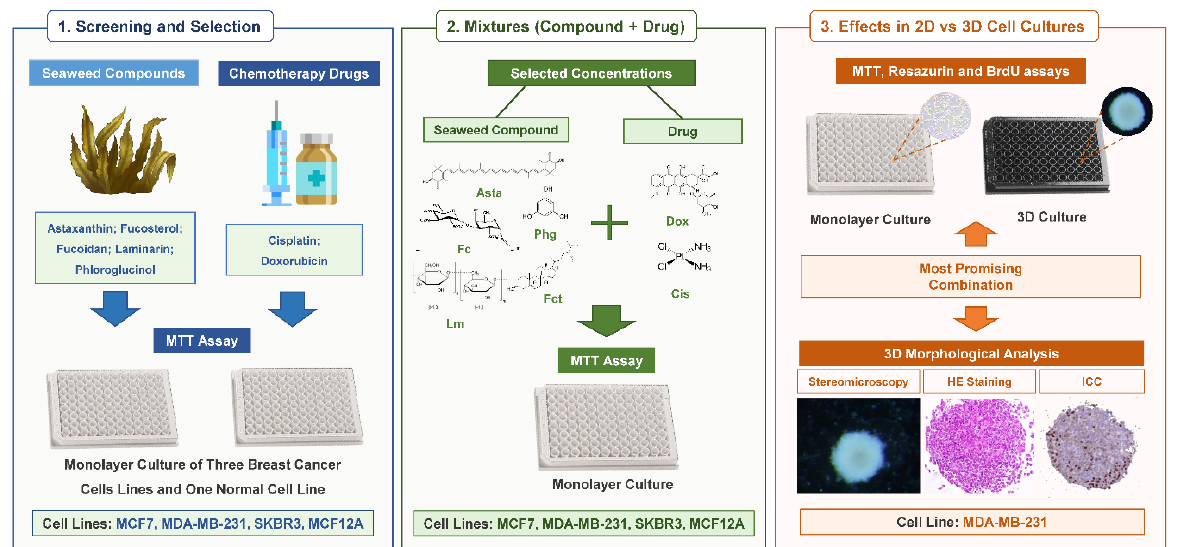
Figure 1. Schematic representation of the study design. Table 1. Tested concentrations of bioactive seaweed compounds and reference drugs Chemicals Tested Concentrations Astaxanthin 1; 10; 50; 100 and 200 µ M